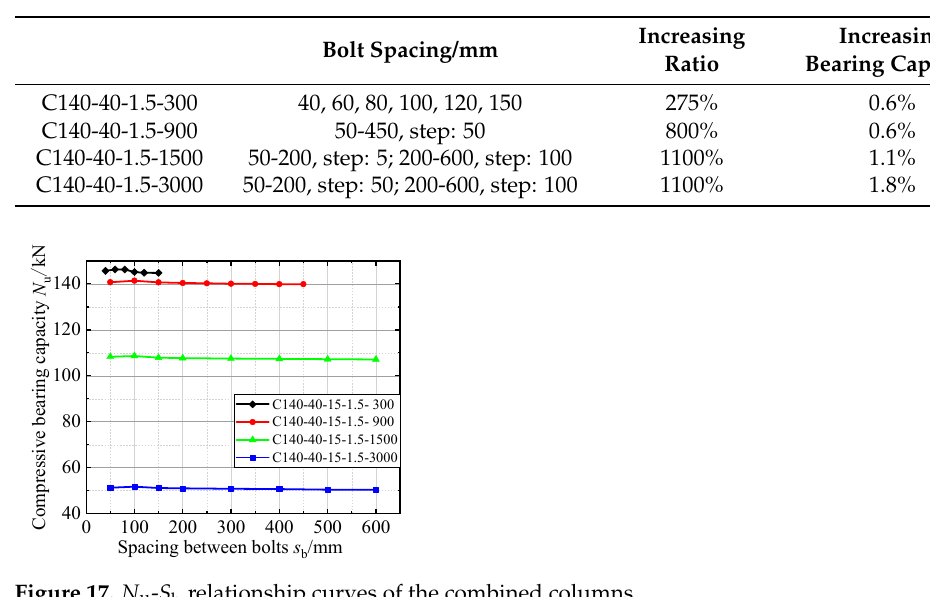
( c ) Figure 18. Failure modes of the combined columns with different opening ratios ( a ) L300; ( b ) L1500; ( c ) L3000.